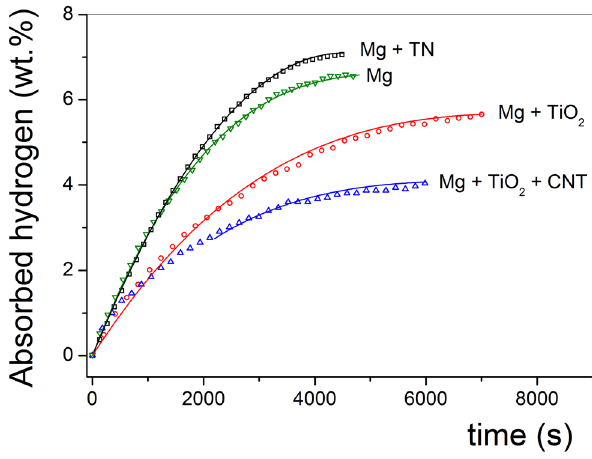
Figure 7: Absorption kinetic curves of the Mg - based composites processed by ECAP.